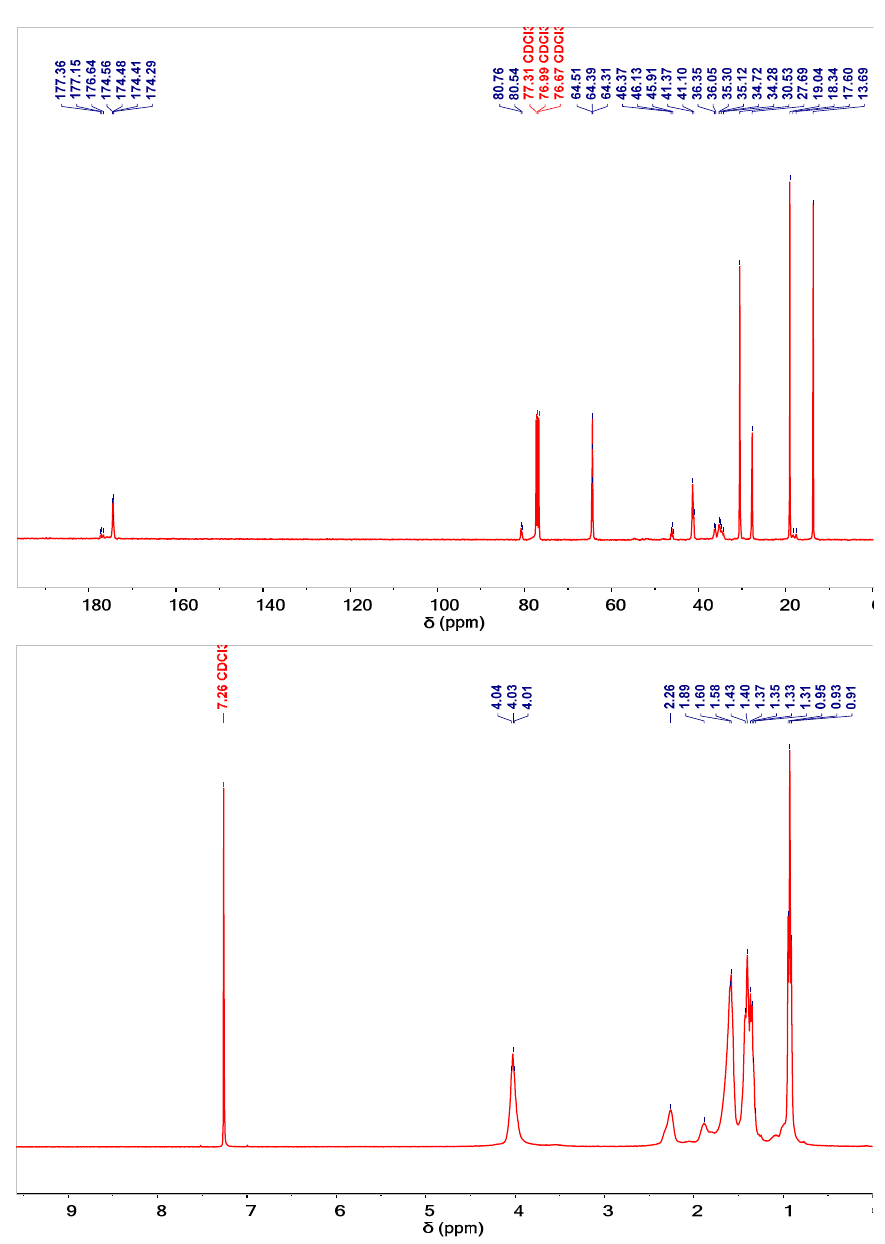
Figure 2. 1 HNMR and 13 CNMR spectra of the low gloss acrylic resin with crosslinker AMA content 0.2 wt % in CDCl 3